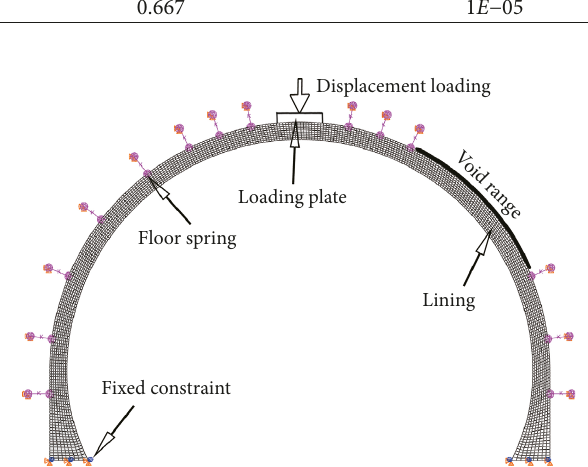
Figure 6: Calculation model of typical structures with